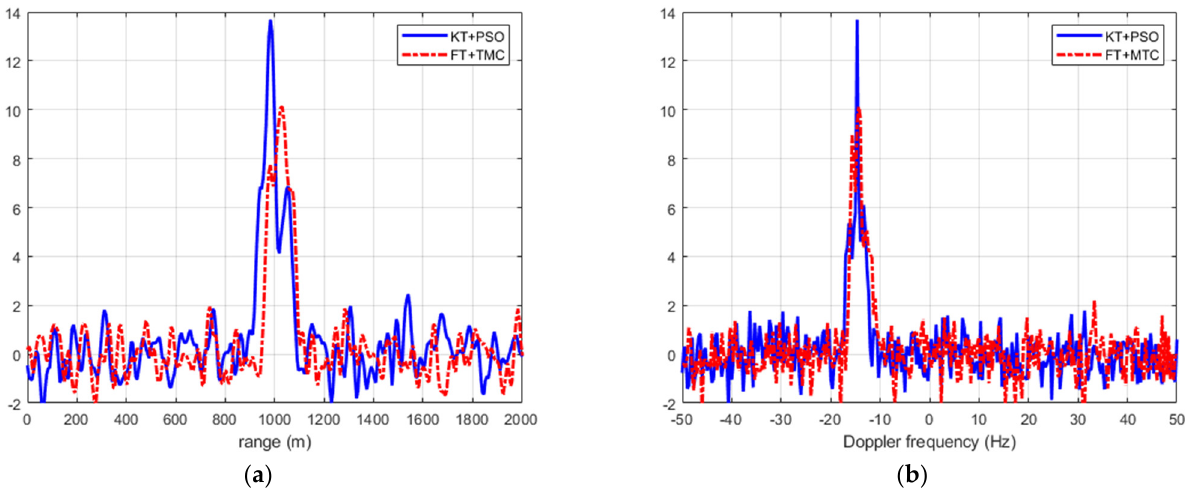
Figure 8. Cross-sections of the RD maps: ( a ) range cross-sections and ( b ) Doppler cross-sections.